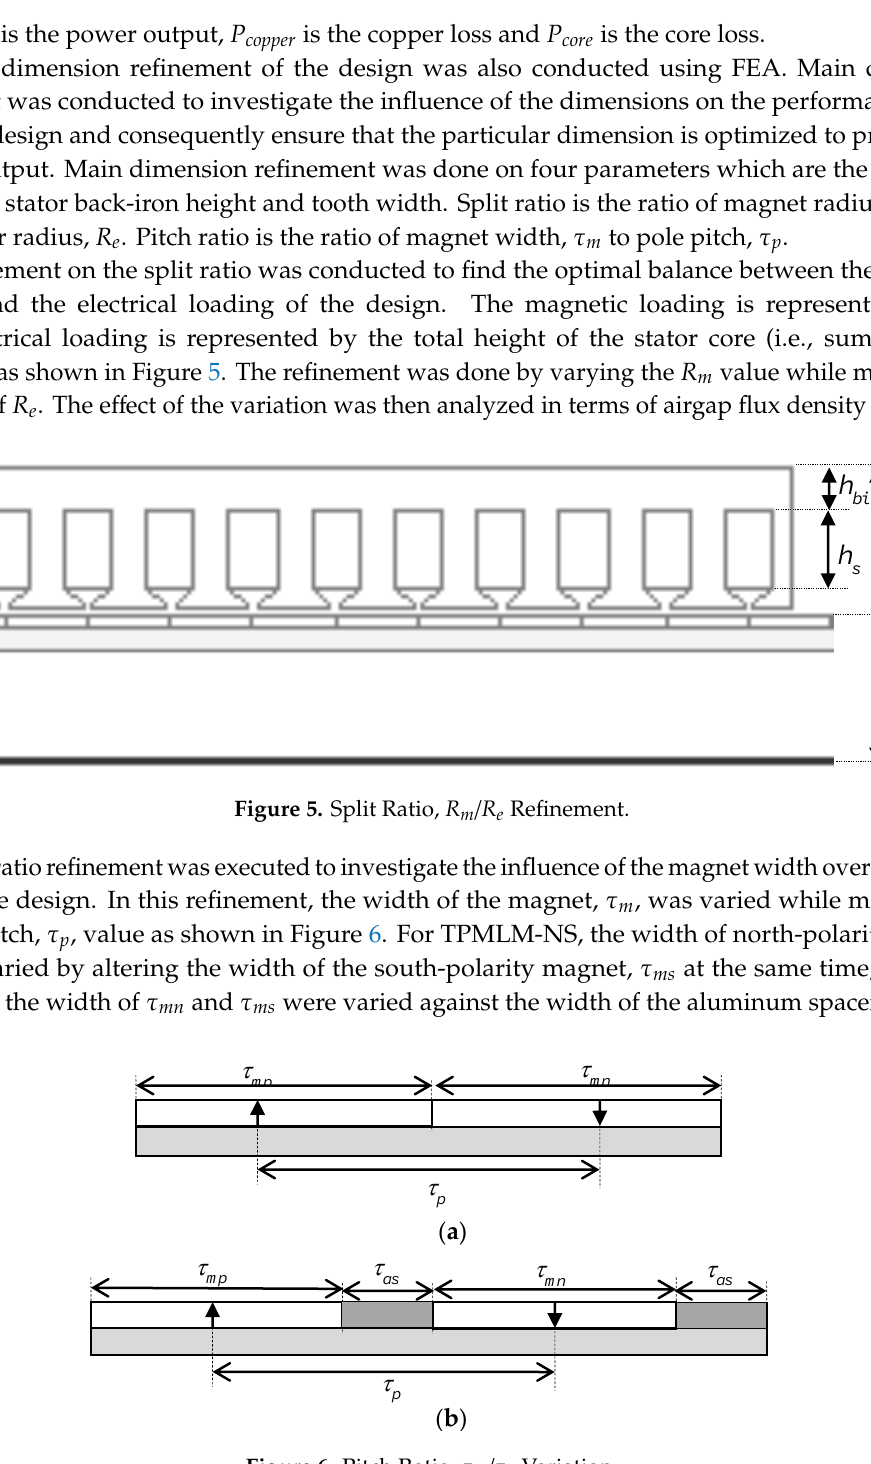
Figure 6. Pitch Ratio, τ m / τ p Variation.